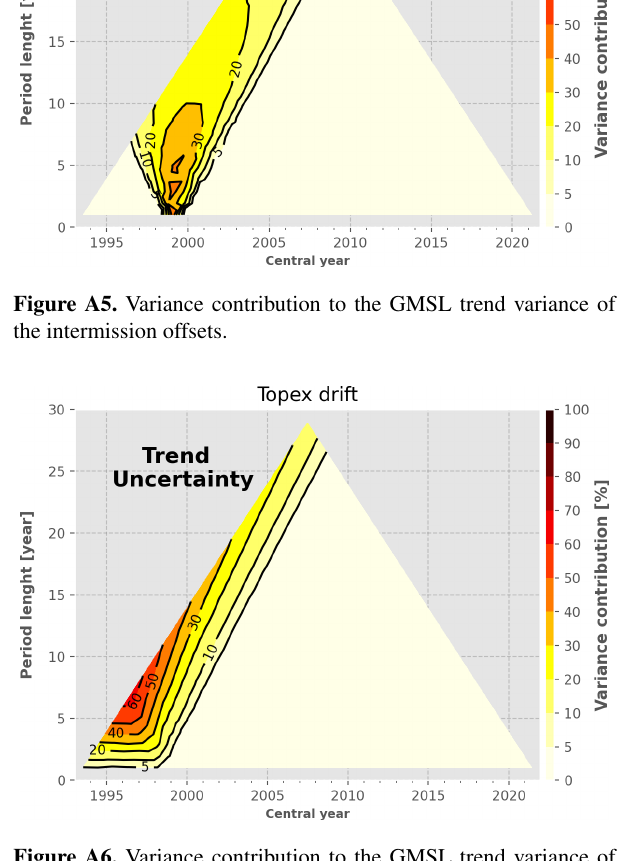
Figure A6. Variance contribution to the GMSL trend variance of TP data